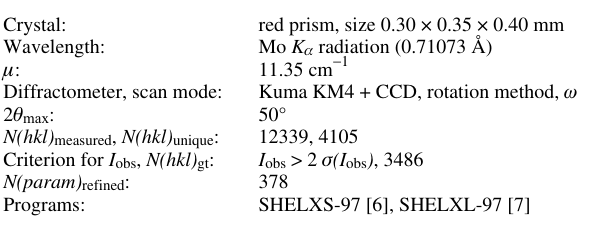
Table 1. Data collection and handling.